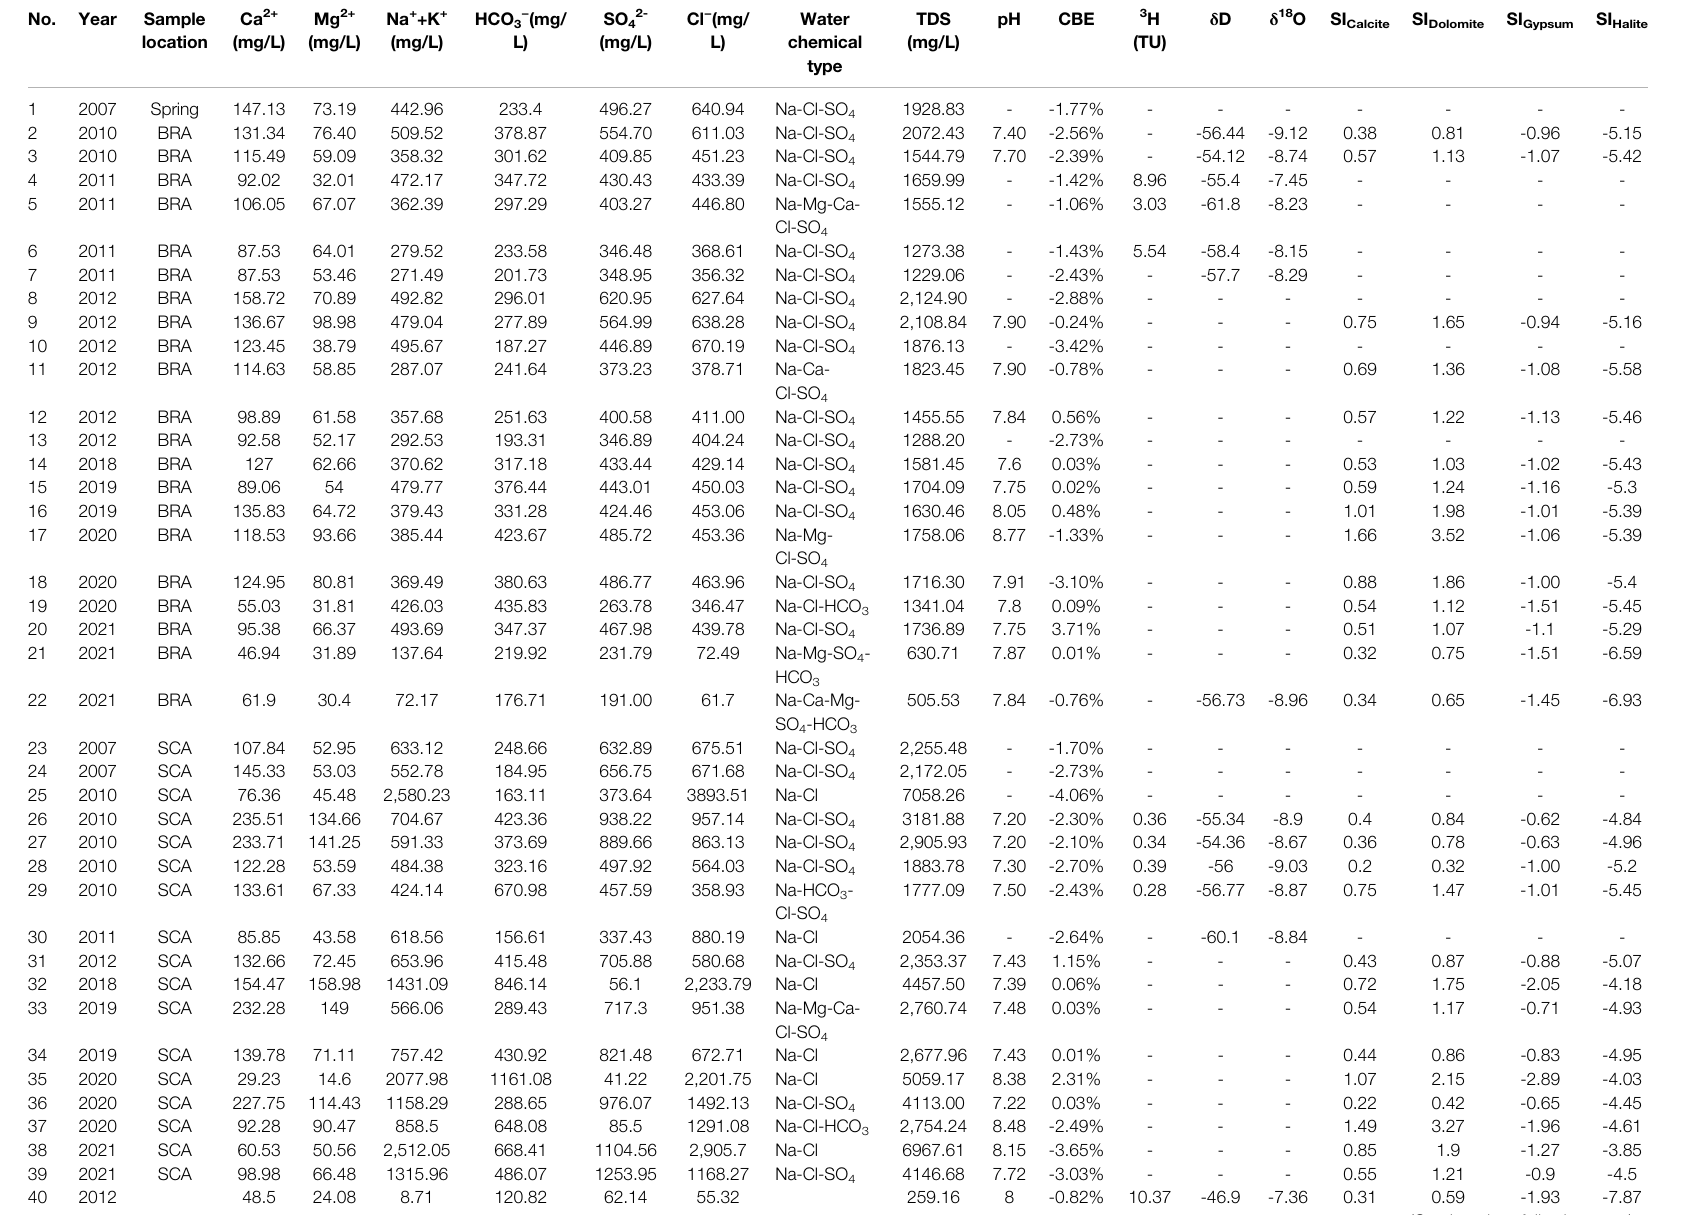
TABLE 1 | Hydrogeochemical data from the study area. No.